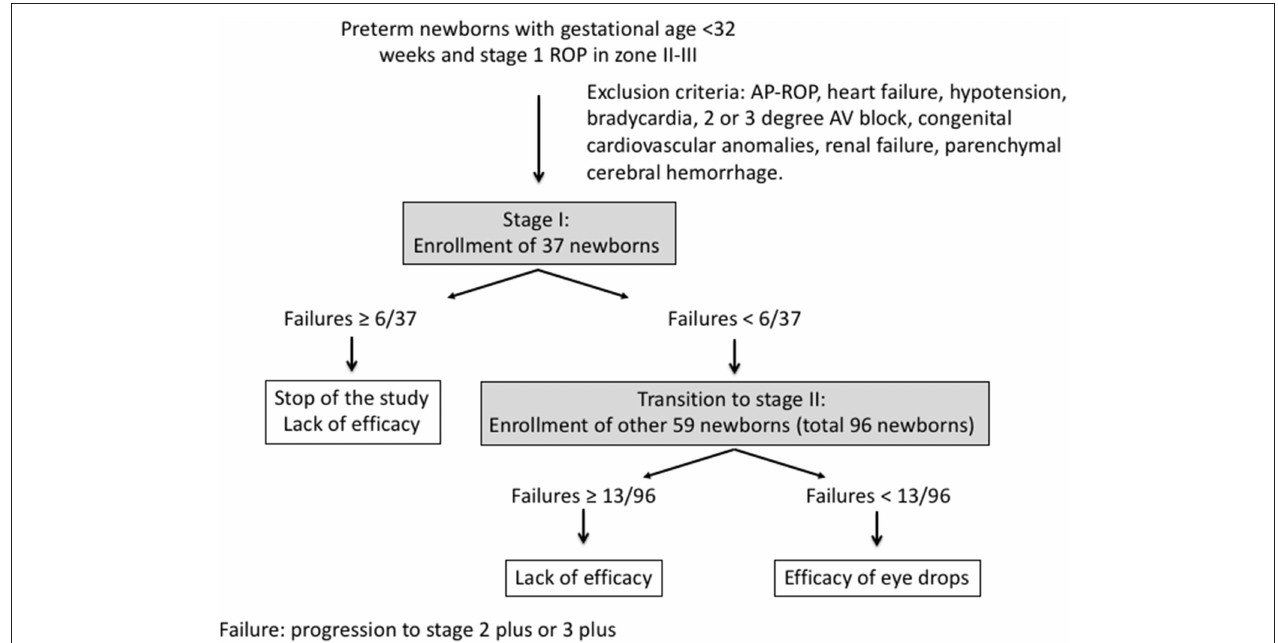
FIGURE 1 | The Simon two-stage optimal design algorithm of the study.